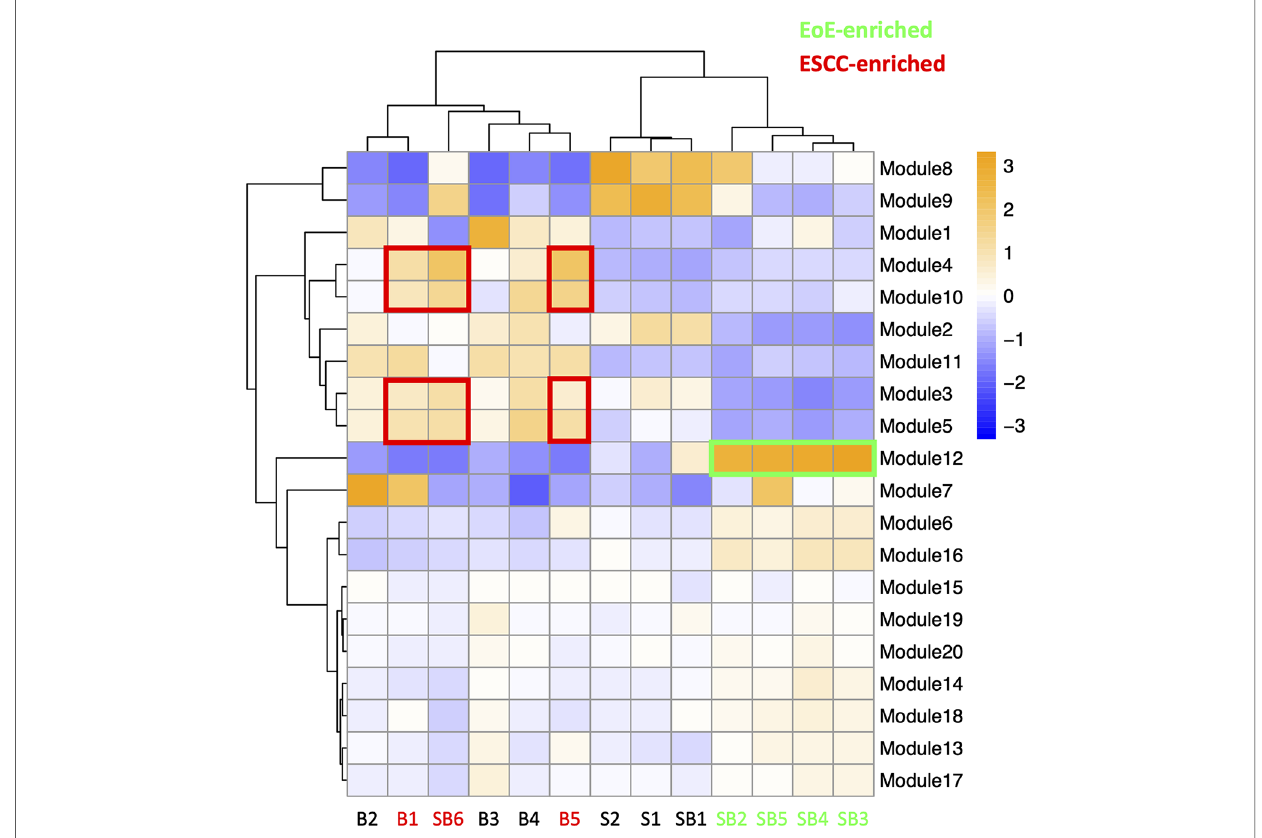
FIGURE 5 Modules of co-expressed genes and their z-score scaled normalized expression in cell populations across the single cell RNA-sequencing dataset. A positive value (orange) indicates upregulation while a negative value (blue) indicates inhibition of the respective genes in each module. Cell populations and modules that are enriched in mice with eosinophilic esophagitis (EoE) are highlighted in green. Cell populations and modules that are enriched in mice with esophageal squamous cell carcinoma (ESCC) are highlighted in